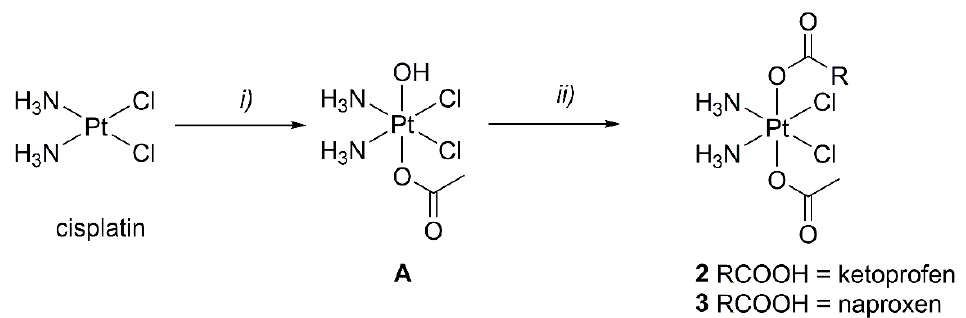
Figure 3. Scheme of the syntheses used in this work: ( i ) 50% w / w H 2 O 2 in CH 3 COOH (room temperature, 4 h), ( ii ) acyl chloride of non-steroidal anti-inflammatory drugs (NSAIDs) in acetonitrile, under microwave heating (55 °C, 1 h).